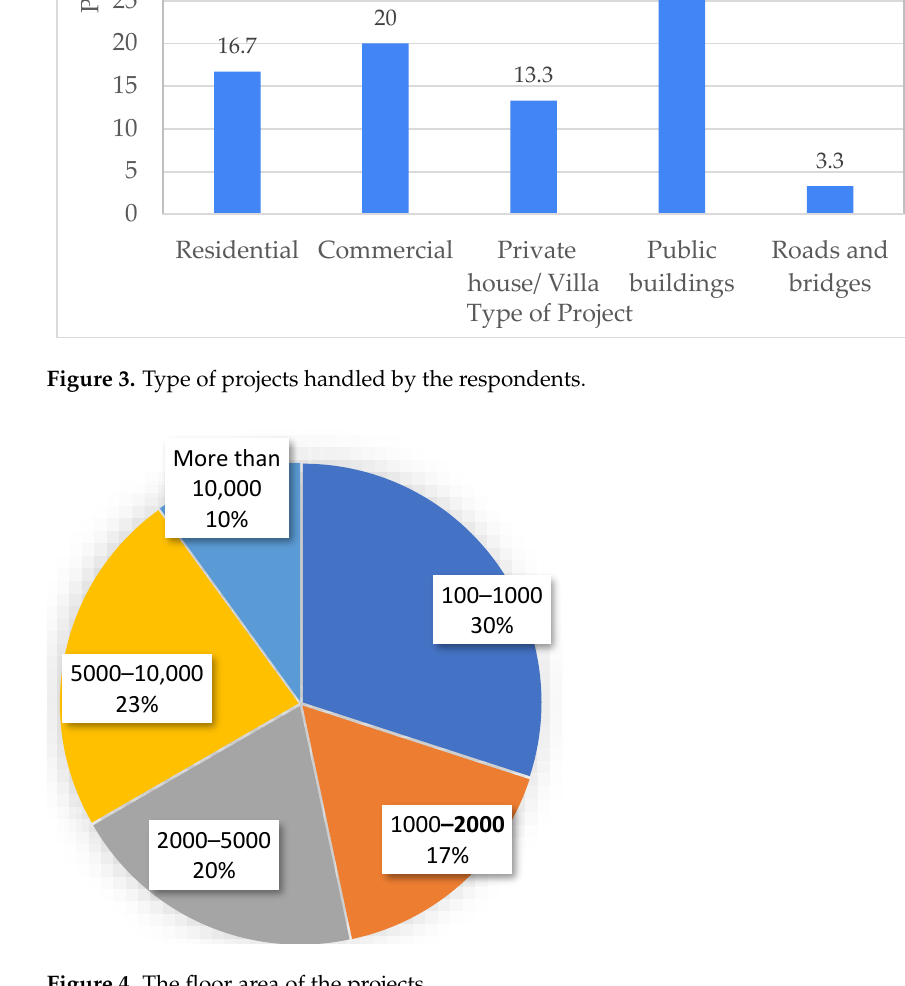
Figure 4. The floor area of the projects.